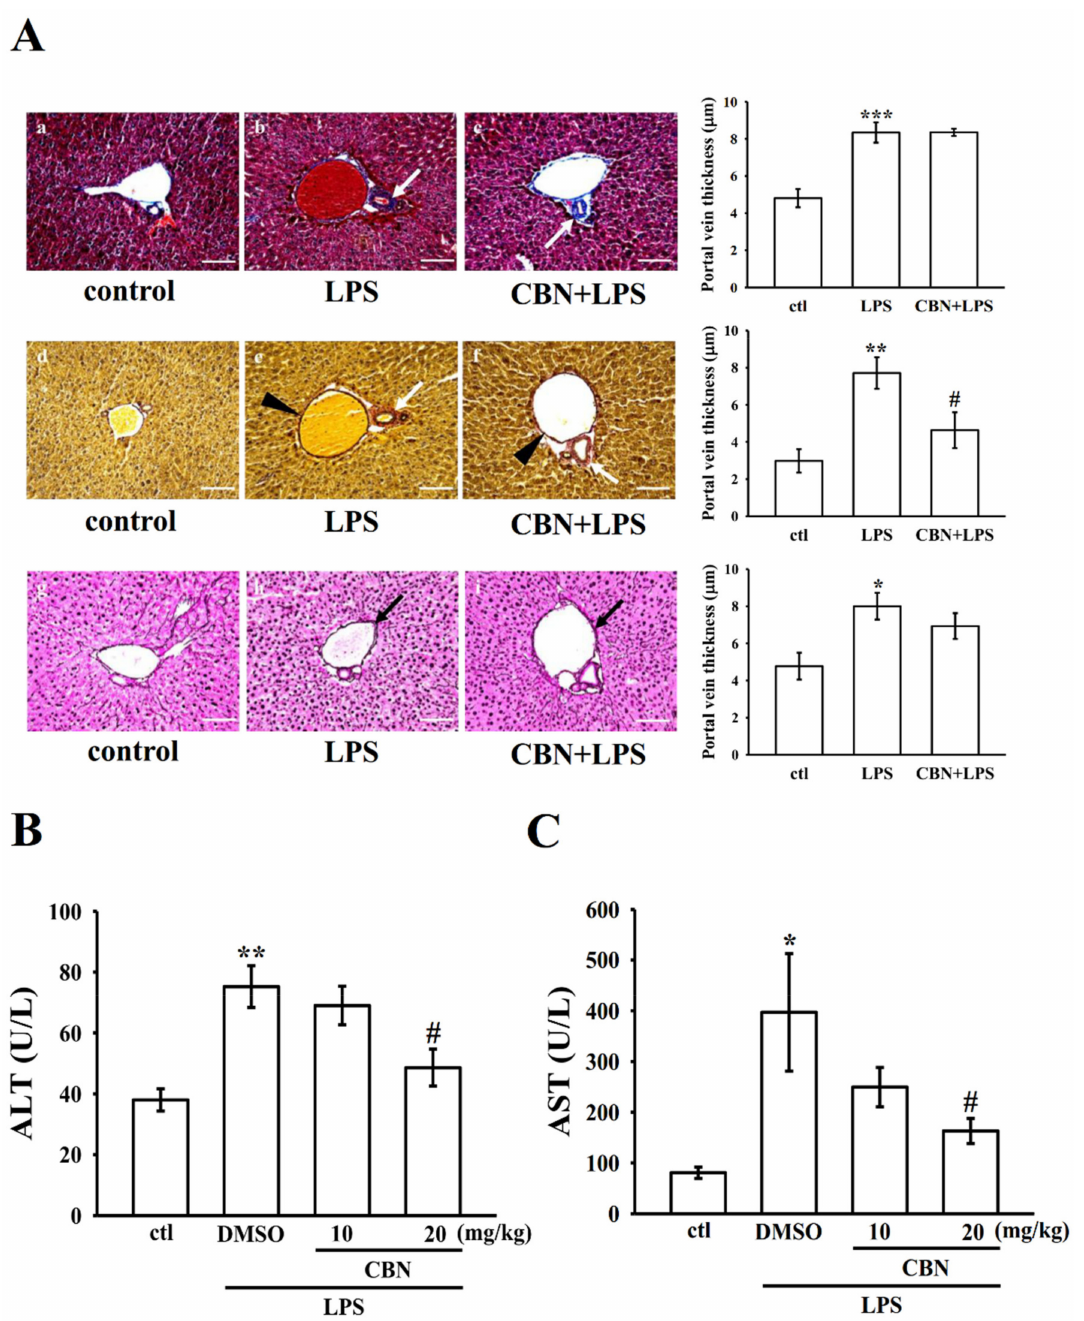
Figure 5. CBN dampens the LPS-induced hepatic injury in mice. ( A ) Effect of CBN on the histological alterations in liver tissue. Trichrome stain ( a – c ). The white arrow indicates the collagen deposition in the portal triad region of liver tissues. More abundant collagen fibers surrounded by arteriole and bile duct in LPS- and CBN + LPS-treated groups as compared to the control group. Weigert’s resorcin fuchsin stain ( d – f ). Collagen fibers (red fibers indicated by white arrows) and elastic fibers (dark blue fibers indicated by black arrowheads) in control, LPS, and CBN + LPS groups. Reticulum stain ( g – i ). A network of fine black reticular fibers identified between the sinusoids and the plates of hepatocytes (indicated by black arrow) in the control, LPS, and CBN + LPS groups. The thickness of the portal vein was calculated using MShot Image Analysis System. Bar = 100 µ m. ( B , C ) CBN reduces LPS-induced serum alanine aminotransferase (ALT) and aspartate aminotransferase (AST) activities. Illustrative views of control, LPS, CBN (20 mg/kg) + LPS groups are presented (magnification 20x). Data presented are the means ± S.E.M. ( n = 6); * p < 0.05, ** p < 0.01, and *** p < 0.001, LPS vs. control group; # p < 0.05, LPS vs. CBN group. The statistical power range was from